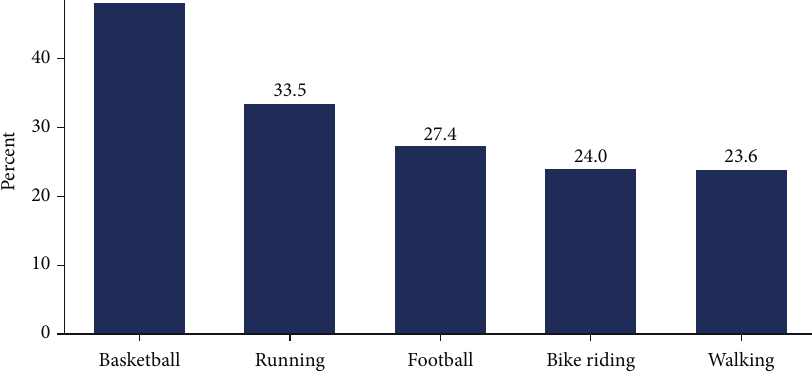
Figure 1: Proportion distribution of curriculum contents of various majors in colleges and